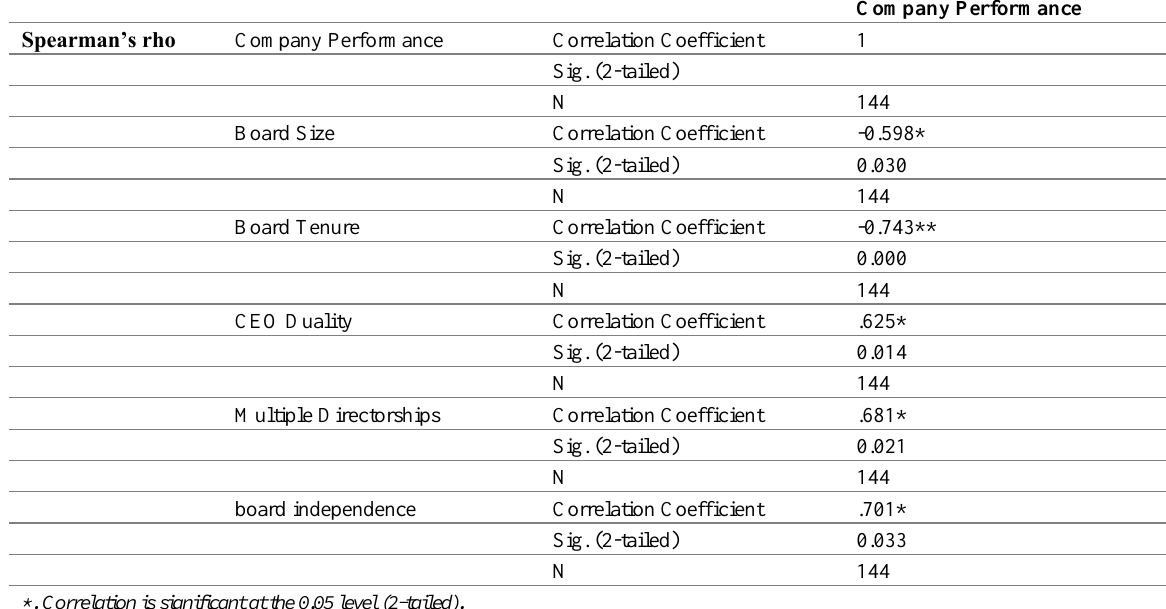
Table 5: Spearman’s Correlation Results